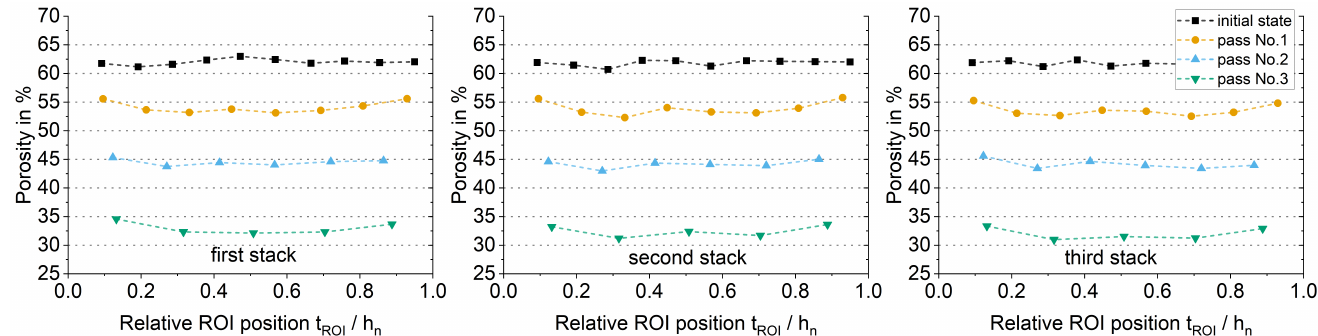
Figure 7. Series I: 5-0.50-3 ( l d / h m ≈ 2.25 − 2.9): Porosity change over relative sample depth (0=upper surface; 0.5= mid-section of sample; 1 =lower surface) due to rolling for first, second and third stack.